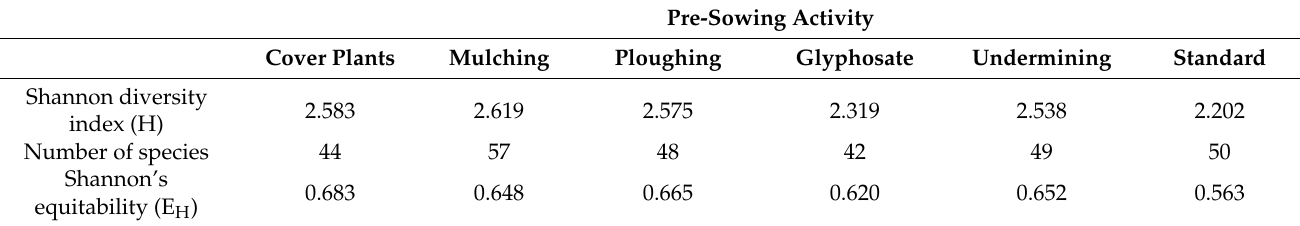
Table 9. Shannon diversity index (H) and Shannon’s equitability (EH) of collected fauna in different pre-sowing